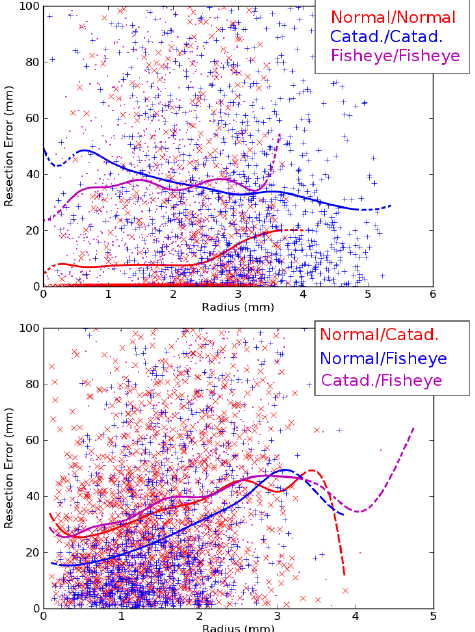
Figure 8: Error Evaluation of Two Camera Systems; The up- per graph shows the error plot for homogeneous systems, which reflects similar projective distortion at roughly the same radial sensor distance (small base line). Below are heterogeneous sys- tems, the maximum of both radii is used for plotting. Solid lines represent smoothed least squares fit of the data (Splines). Dashed parts are with little data. Not all of the data is plotted due to heavy cluttering of the